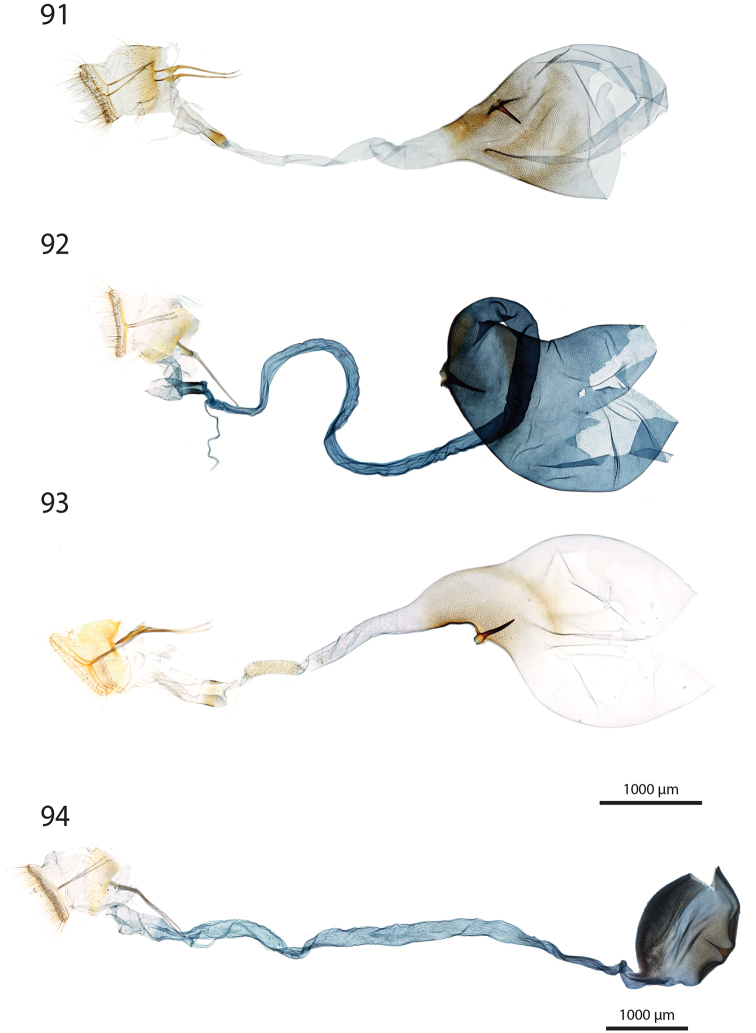
Female genitalia features of Hoploscopa. 91Hoploscopa
parvimacula sp. nov., paratype, TL551 ♀ 92Hoploscopa
kinabaluensis sp. nov., TL674 ♀ 93Hoploscopa
luteomacula, paratype, GU prep. Nuss 743 ♀ 94Hoploscopa
obliqua, paratype, TL656 ♀.